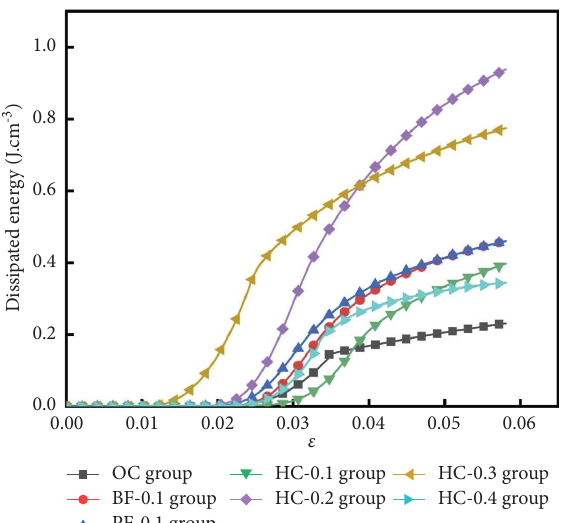
Figure 8: Evolution law of elastic strain